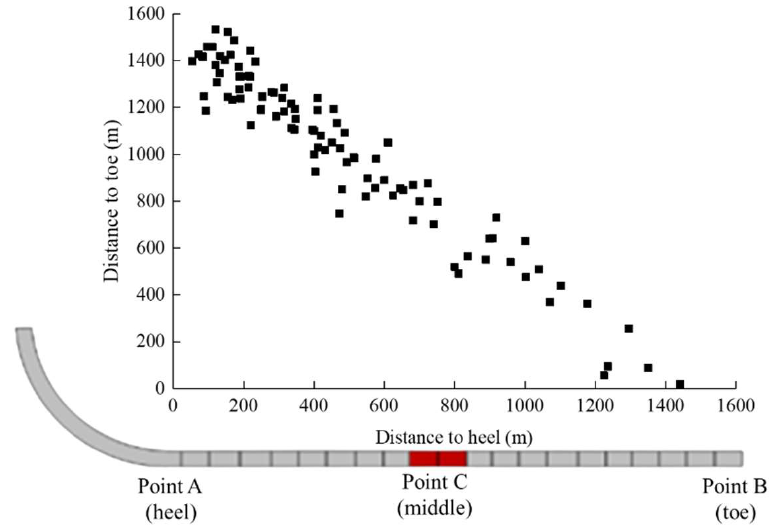
Figure 3. Distribution features of the casing deformation points.